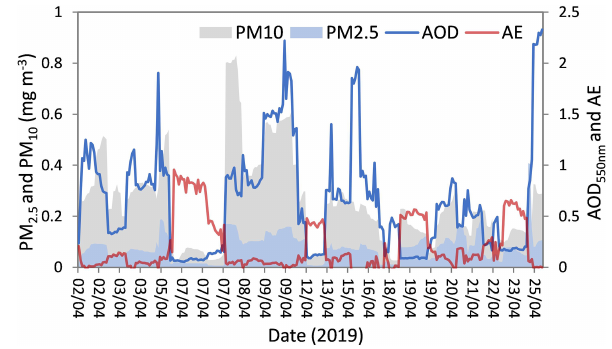
Figure 4. Variations of aerosol optical depth (550nm), Ångström exponent (440–870nm), and PM 2 . 5 and PM 10 mass concentrations at the Kashi site during the DAO-K